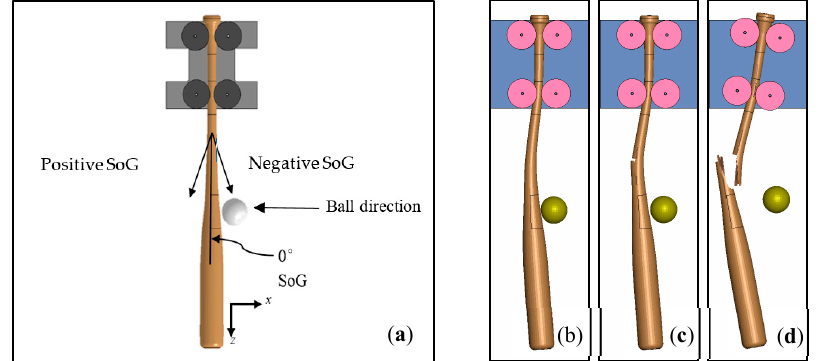
Figure 2. Finite element analysis terminology ( a ) Sign convention used in the finite element models ( b ) no failure (NF); ( c ) single-piece failure (SPF) outcome; and ( d ) multi-piece failure (MPF)